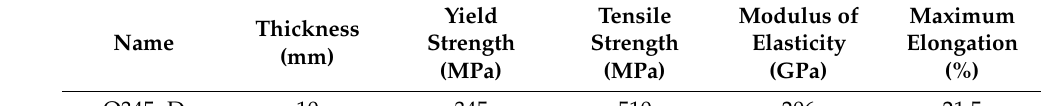
Table 1. Materials parameters of steel plates.